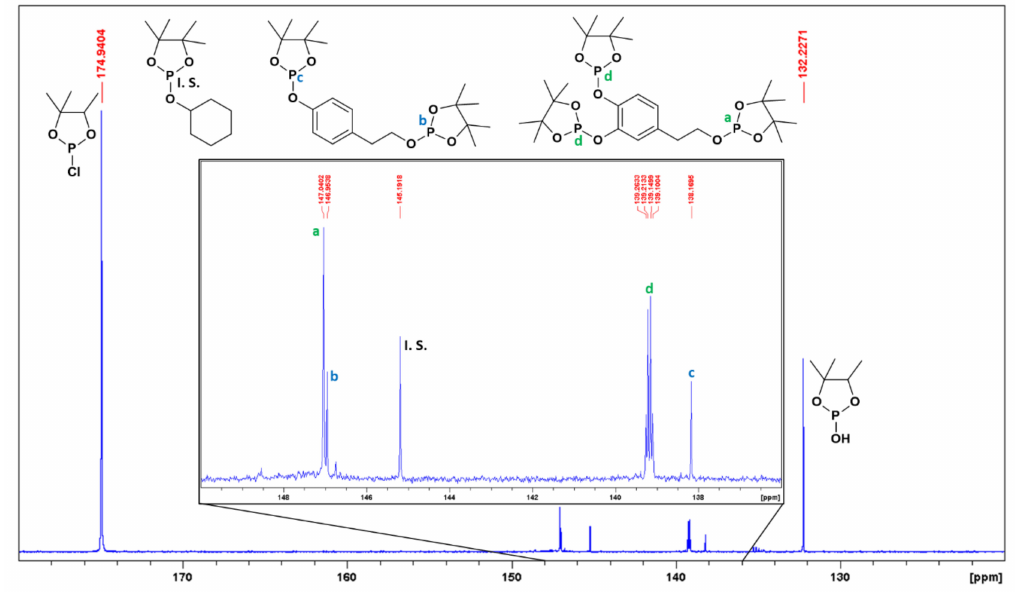
Figure 8. 31 P-NMR spectrum (400 MHz, CDCl 3 + pyridine) from S1 organic phase after ethyl acetate extraction and derivation process with